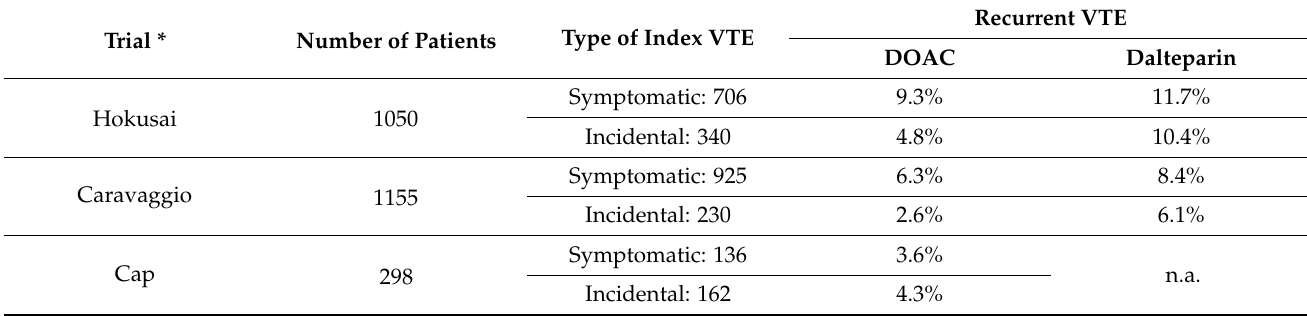
Table 6. Recurrent VTE based on symptomatic or incidental index